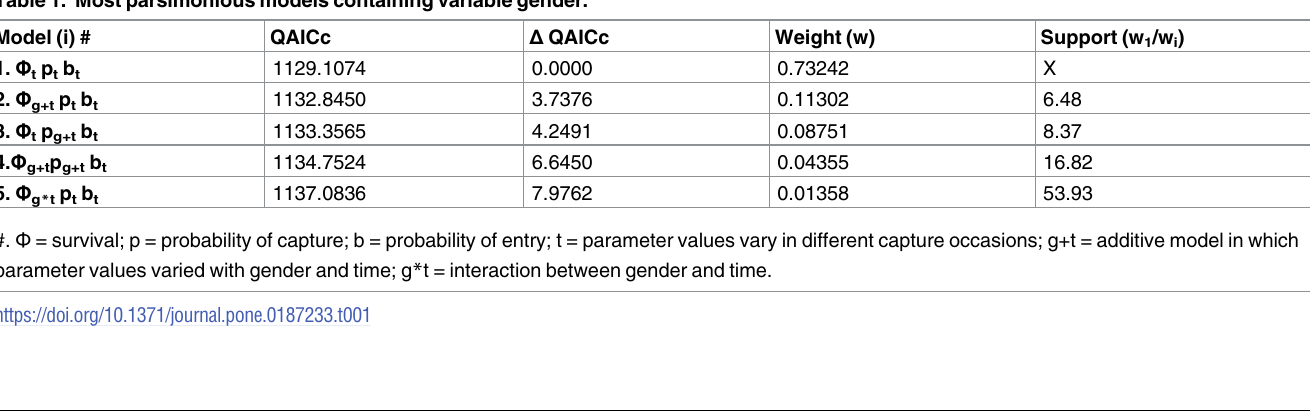
Table 1. Most parsimonious models containing variable gender. Model (i) #